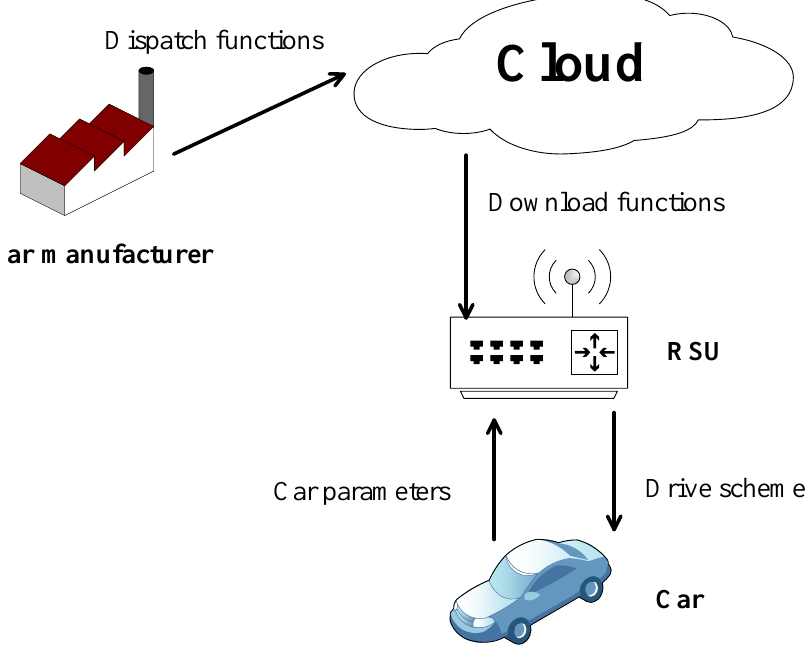
Figure 1. The architecture of a typical ITS